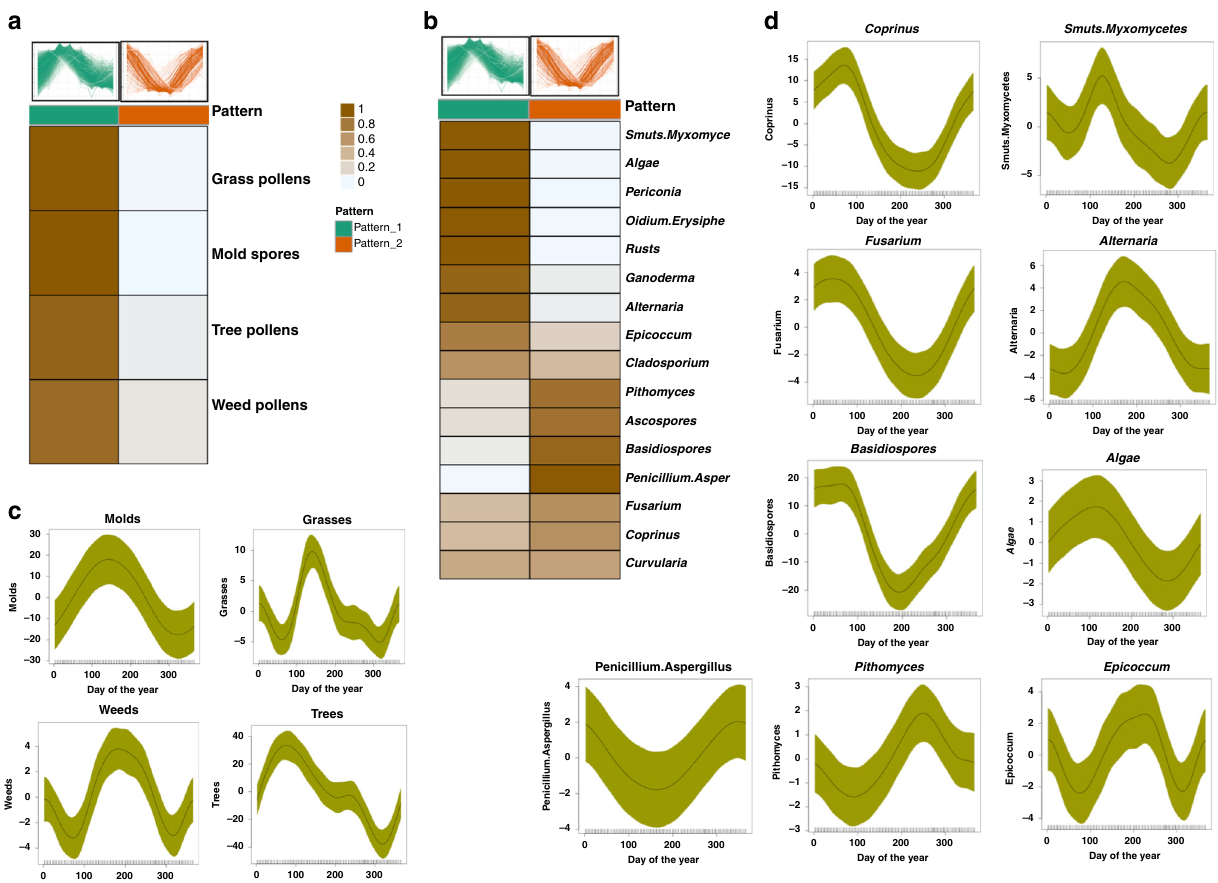
Fig. 5 Airborne pollens and fungi correlate with omics seasonal patterns. Correlation of ( a ) pollen counts (tree pollens, weed pollens, mold spores, grass pollens), and ( b ) airborne fungi with the two omics seasonal patterns. The heatmap shows cluster membership values (which are on a scale of 0 and 1) based on existing cluster centroids (omics pattern one is shown in green color and omics patterns two are shown in orange color). Seasonal patterns of tree pollens, weed pollens, mold spores and grass pollens are shown in ( c ) and seasonal patterns of speci fi c airborne fungi are shown in ( d ). The Y -axis shows the days of the year and the X -axis shows normalized pollen counts or normalized airborne fungi counts. The shaded area represents 95% con fi dence bounds computed as ±1.96 standard deviation of model coef fi cients. Standard deviations were derived from a maximum likelihood fi